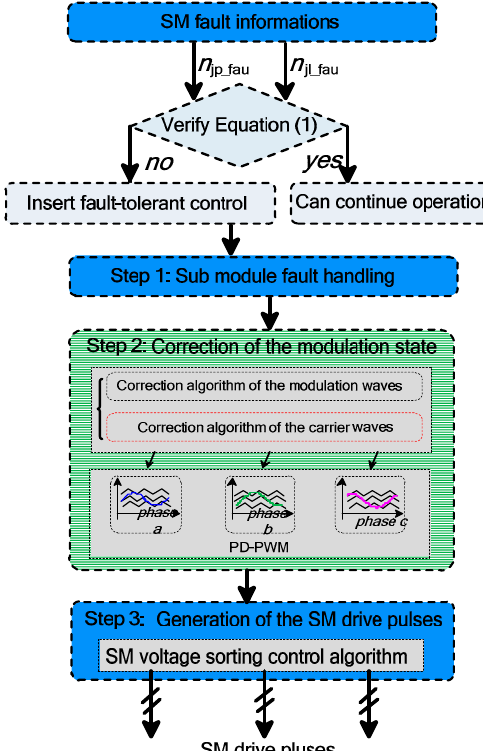
Figure 4. Overall flow chart of the proposed fault - tolerant control strategy.